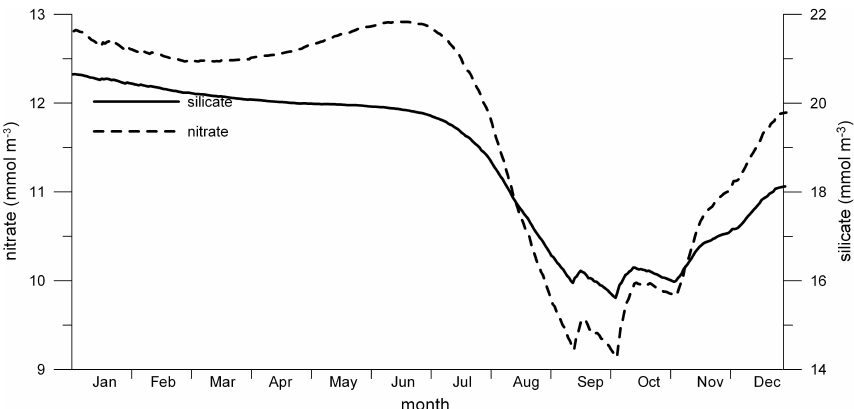
Fig. 7. Modelled annual cycle of surface nitrate and silicate without iron supply in August. Table 1. Measured fluxes and concentrations under undisturbed and disturbed conditions around station